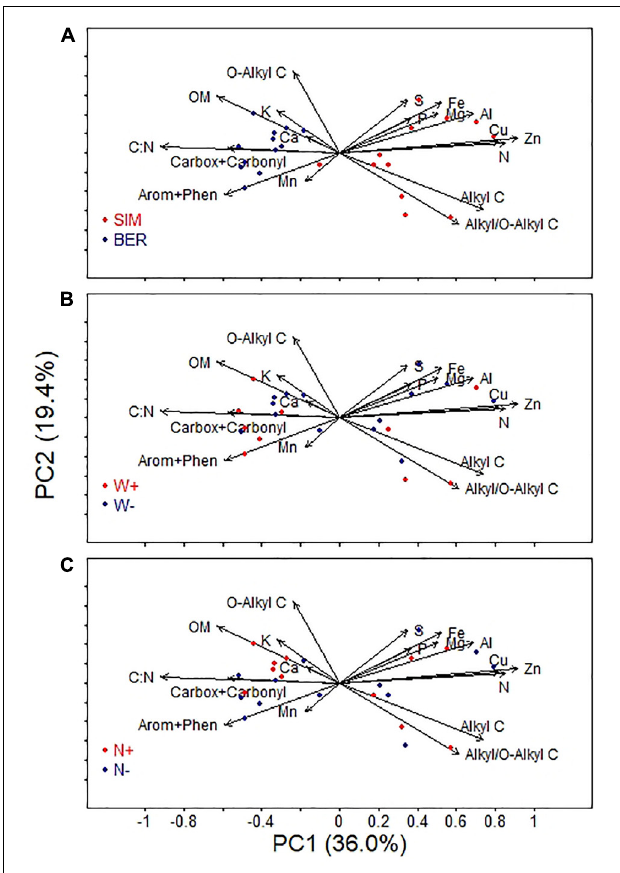
FIGURE 2 | Results of the principal component analysis (PCA). The 18 forest floor chemical variables are projected along with forest floor sample ( n = 24) scores as a function of (A) site, (B) soil warming treatment, and (C) canopy N addition treatment.